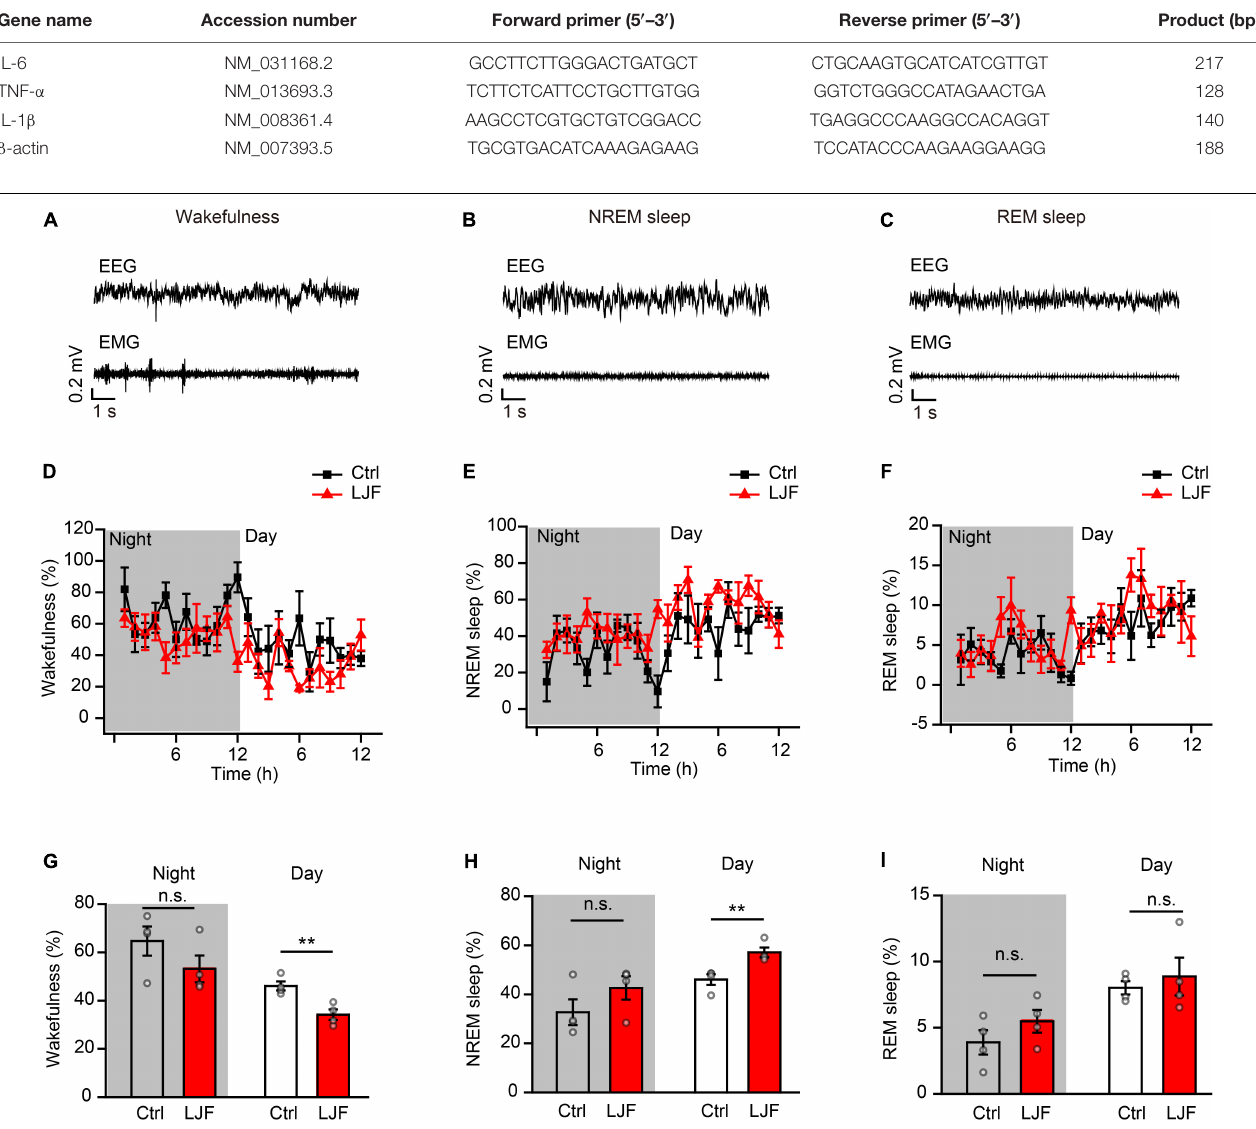
TABLE 1 | Primers for real-time PCR.